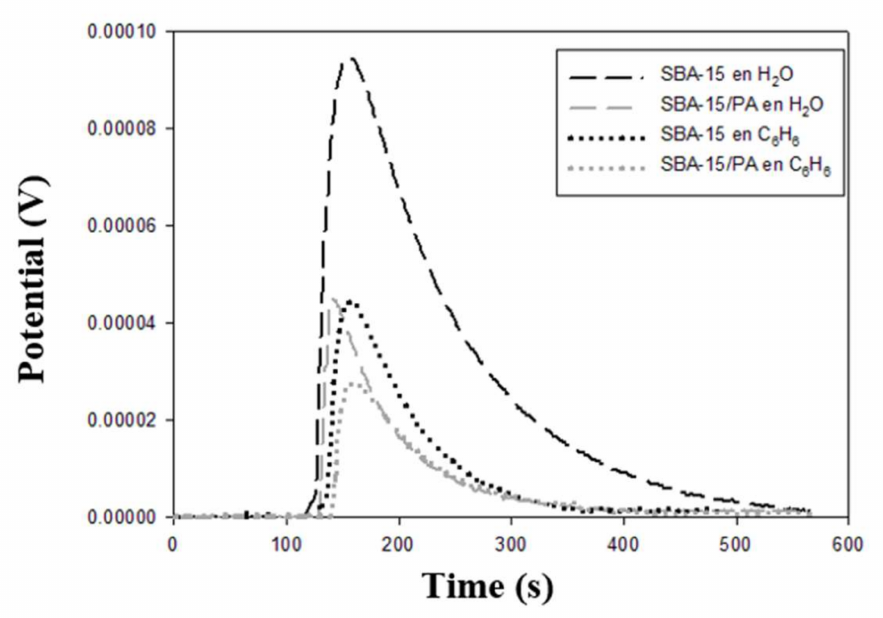
Figure 2. Potentiogram of immersion of the SBA-15 and its modification in water and benzene.